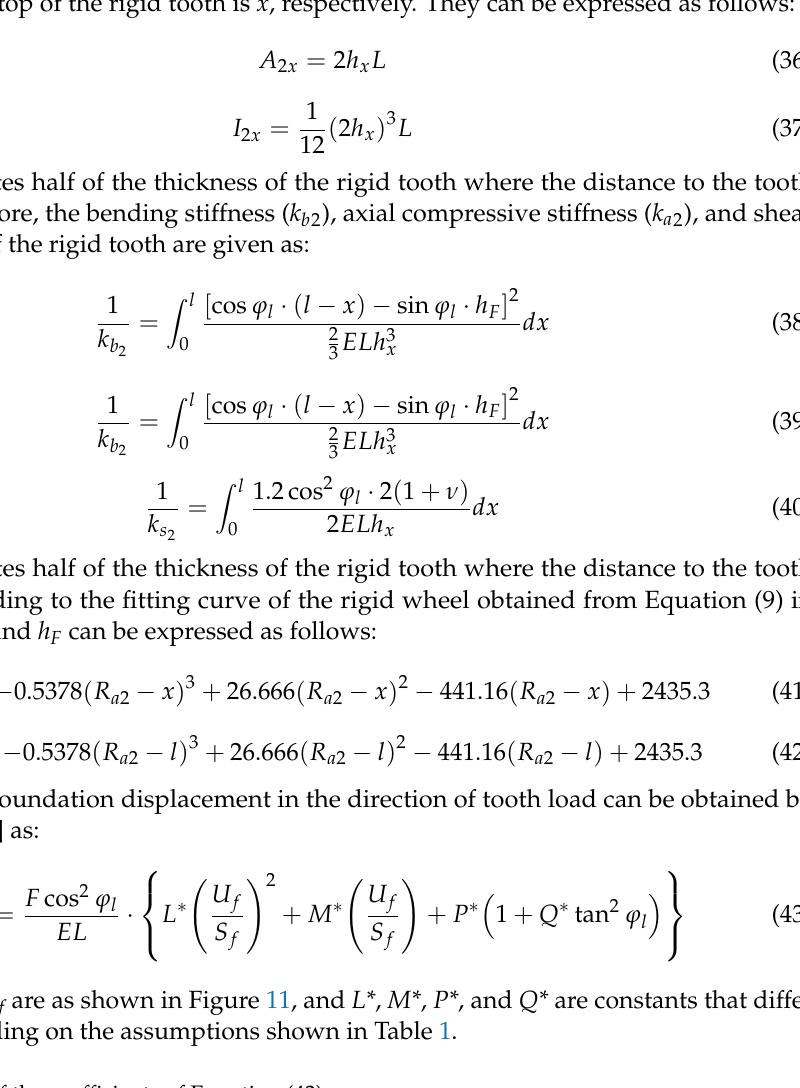
Table 1. Values of the coefficients of Equation